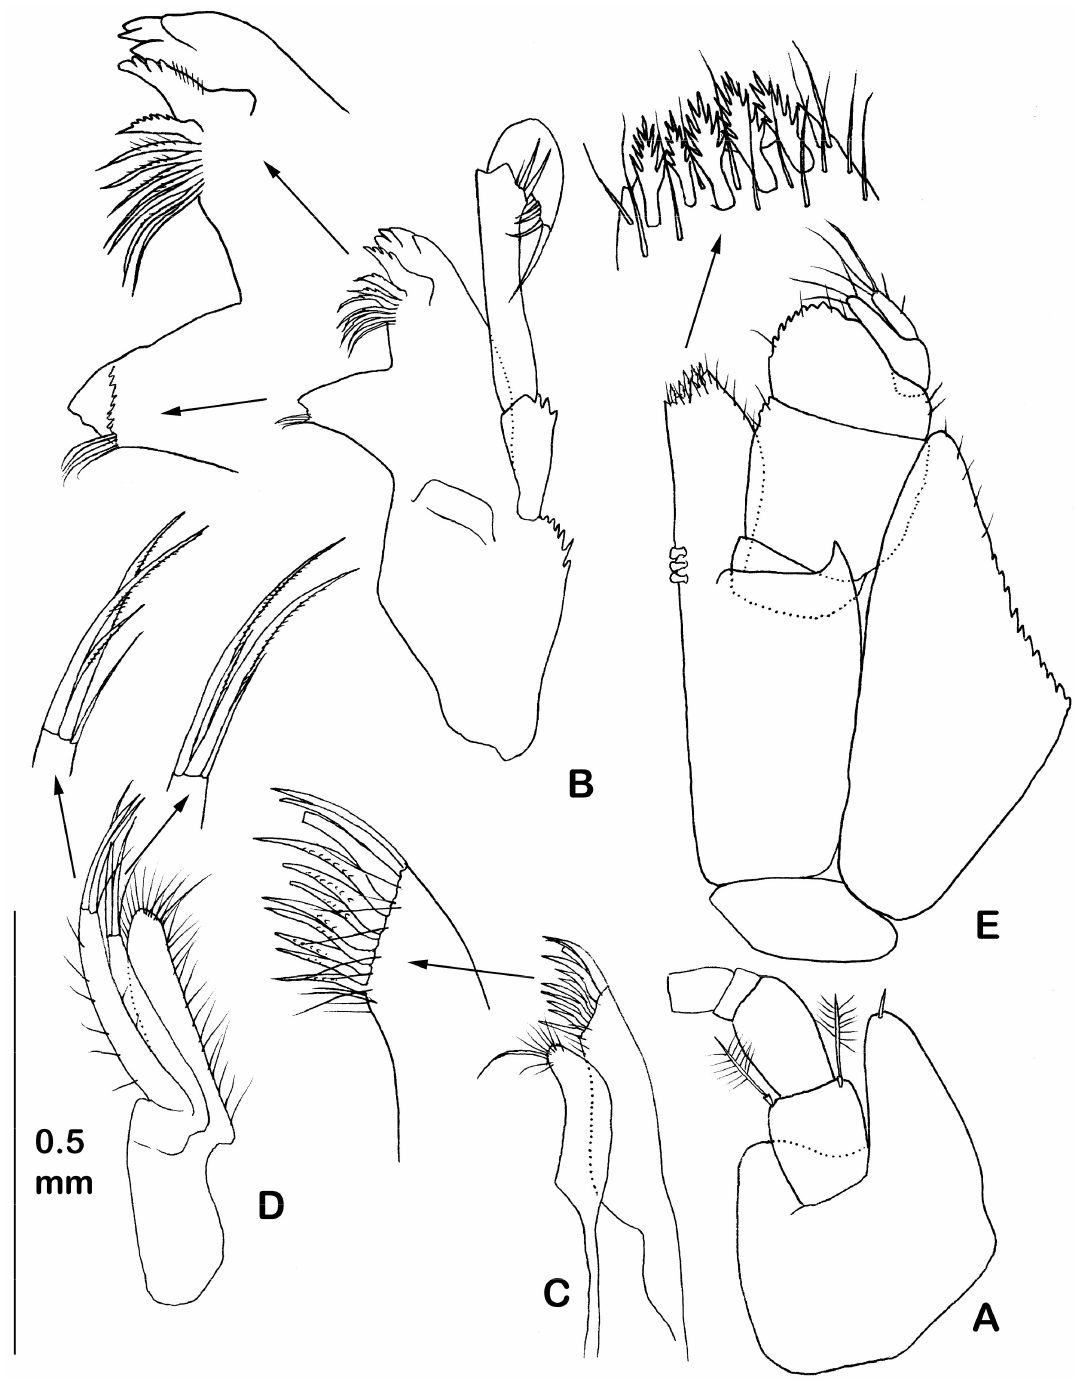
Figure 15. Eurycope mishkai sp. nov. Male paratype (ZMH K-45624): ( A ) antenna I; ( B ) left mandible (incisor and molar process enlarged); ( C ) maxilla I (distal parts enlarged); ( D ) maxilla II (distal parts enlarged); ( E ) maxilliped (distal parts of endite enlarged). Pleopod III (male paratype, ZMH K-45624, Figure 16C) protopod length 0.65 times width; endopod length 1.3 times width, distal margin truncated, width 1.2 times proximal width, with three distal plumose setae, setae length 0.3 times pleopod III length. Exopod subequal in length to protopod and endopod together, width 0.3 times endopod width, with row of fine simple lateral setae; length of thin simple distal seta subequal to endopod distal setae